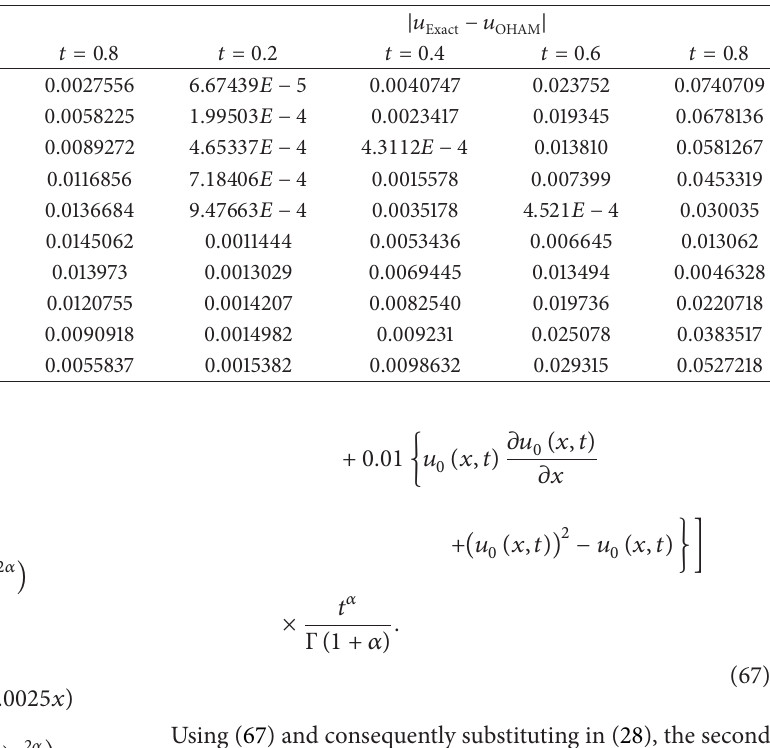
Table 2: The absolute errors in the solution of generalized Fisher’s equation (49) using Haar wavelet method and five terms for fourth-order OHAM with convergence control parameters 𝐶 1 = −0.637012 , 𝐶 2 = −0.151156 , 𝐶 3 = 0.023432 , and 𝐶 4 = −0.0012788 at various points of 𝑥 and 𝑡 for 𝛼 = 1